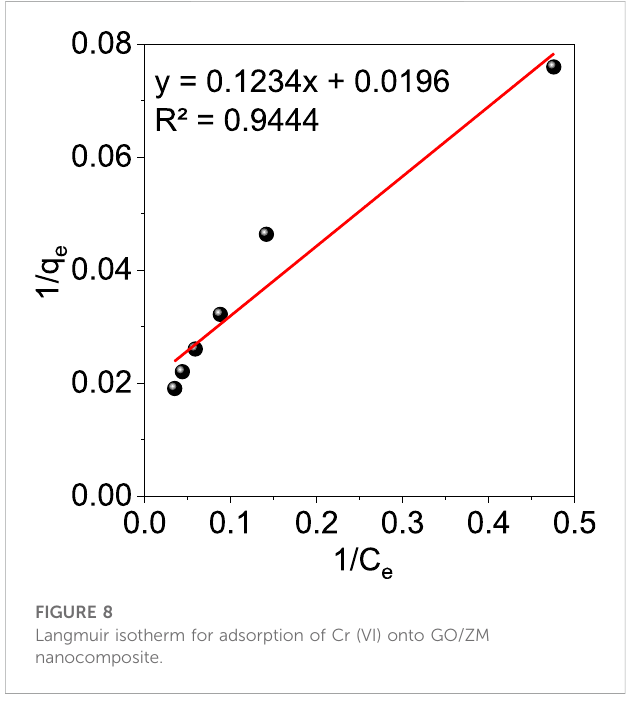
FIGURE 8 Langmuir isotherm for adsorption of Cr (VI) onto GO/ZM nanocomposite.